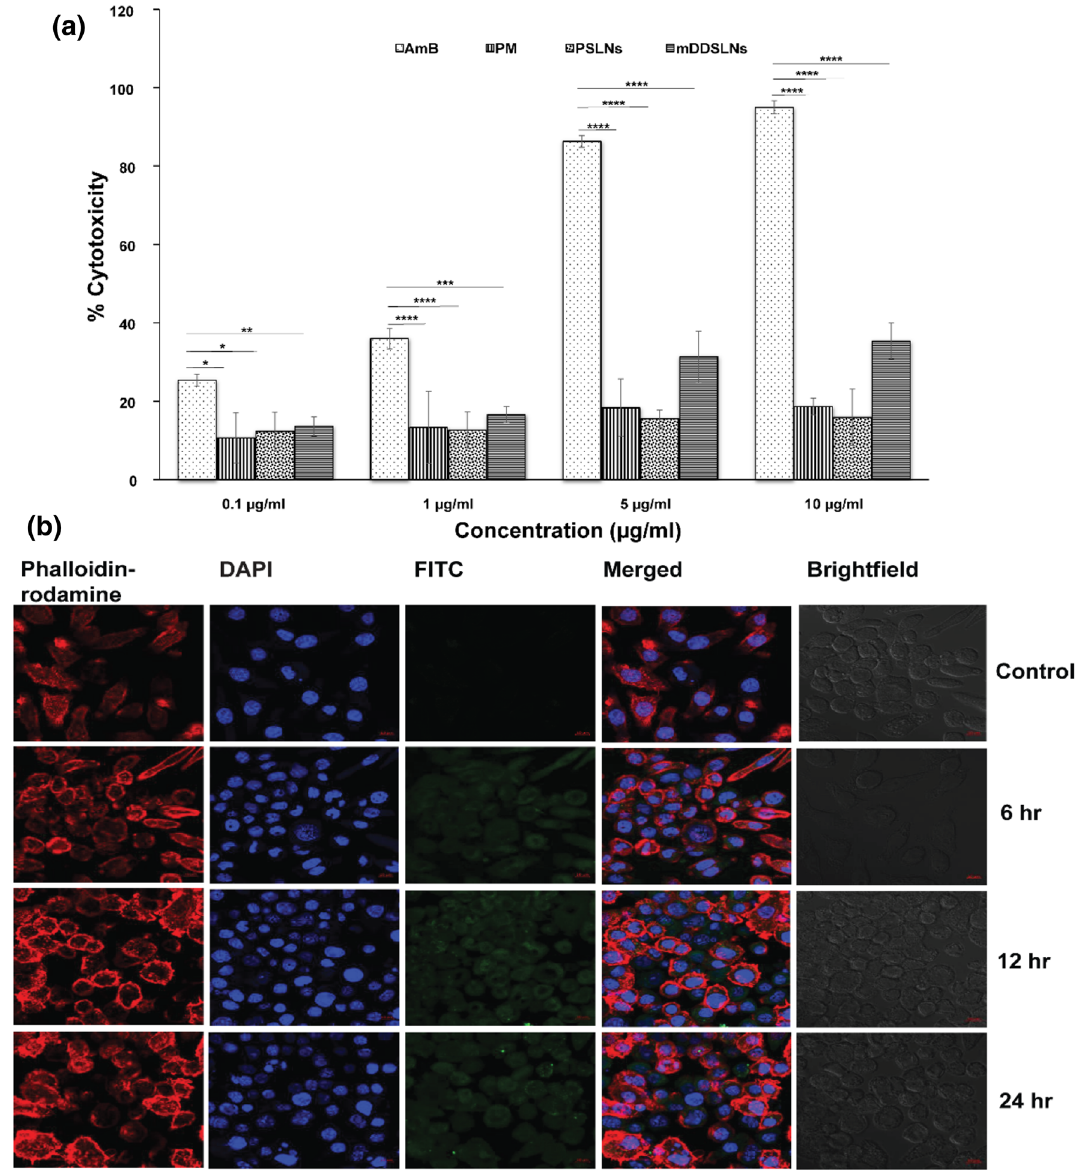
Figure 5. ( a ) % cytotoxicity of macrophage cells (J774A.1) treated with different concentrations 0.1, 1, 5 and 10 µg/ml of AmB, PM, PSLNs, m-DDSLNs. Results are presented as mean ± standard deviation (n = 3). Statistical significance was assessed using two way ANOVA followed by Student’s t-test (* P < 0.05 and ** P < 0.01, *** P < 0.001, **** P < 0.0001) ( b ) Confocal microscopy images of J774.A.1 cells upto 24 h incubation at 37 °C with FITC-SLNs. FITC fluorescein isothiocyanate, hr